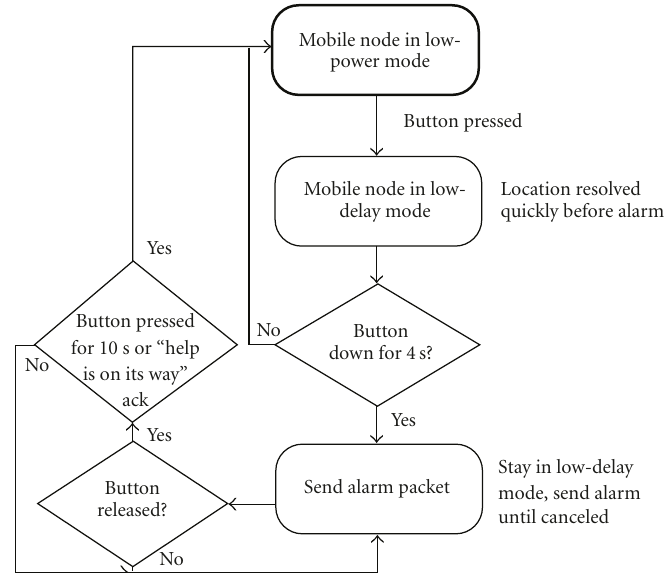
Figure 10: The alarm device operation and the mobile node modes.